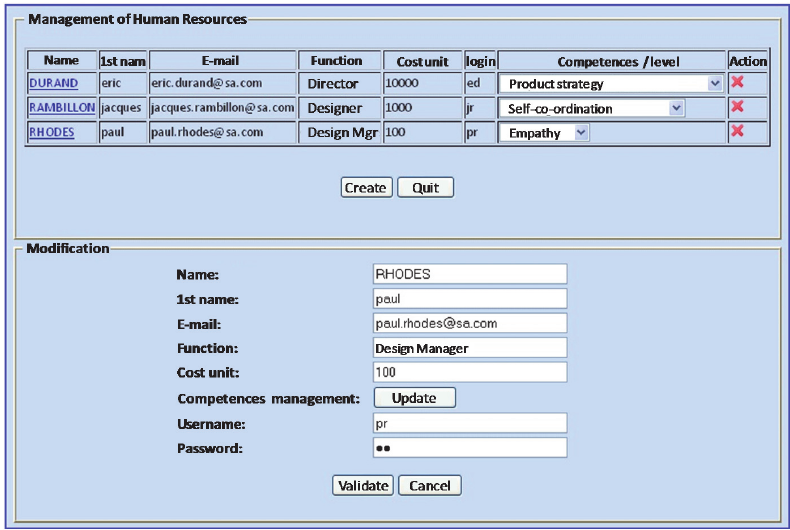
Fig. 6. Competences and Human